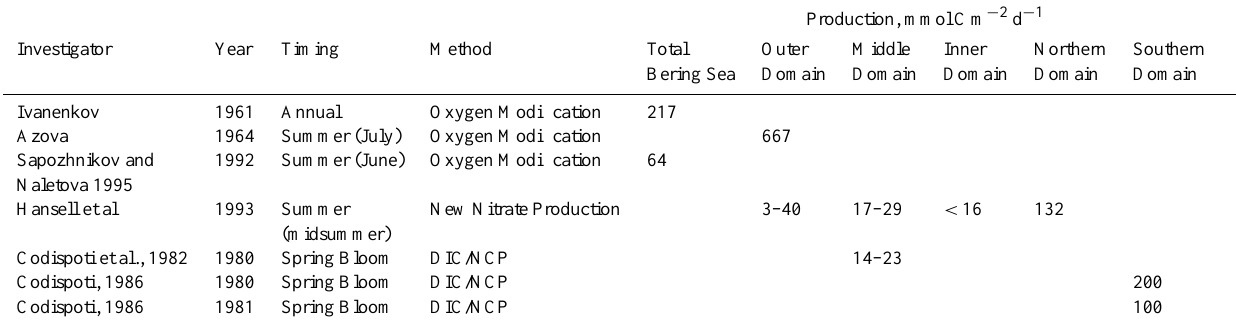
Table 2. Previous estimates of NCP in the Southeastern Bering Sea, calculated using the drawdown in oxygen, nitrogen, and inorganic carbon. Estimates based on oxygen consumption were converted to carbon based production values in the original work. Estimates of nitrate production were converted to carbon-based production within the original study or by using f-ratios of 0.4 for the middle and outer domains and 0.3 for the inner